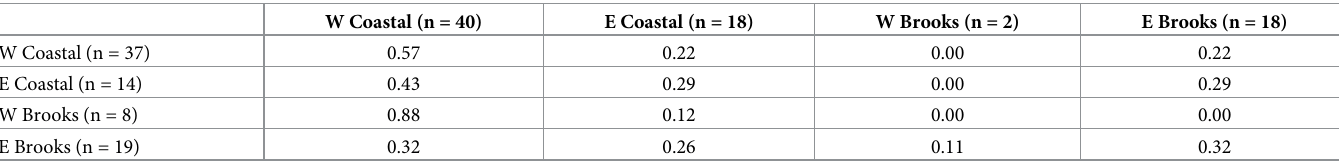
Table 3. Transition probabilities for caribou moving between fine-scale wintering areas in subsequent years. W Coastal (n = 40)